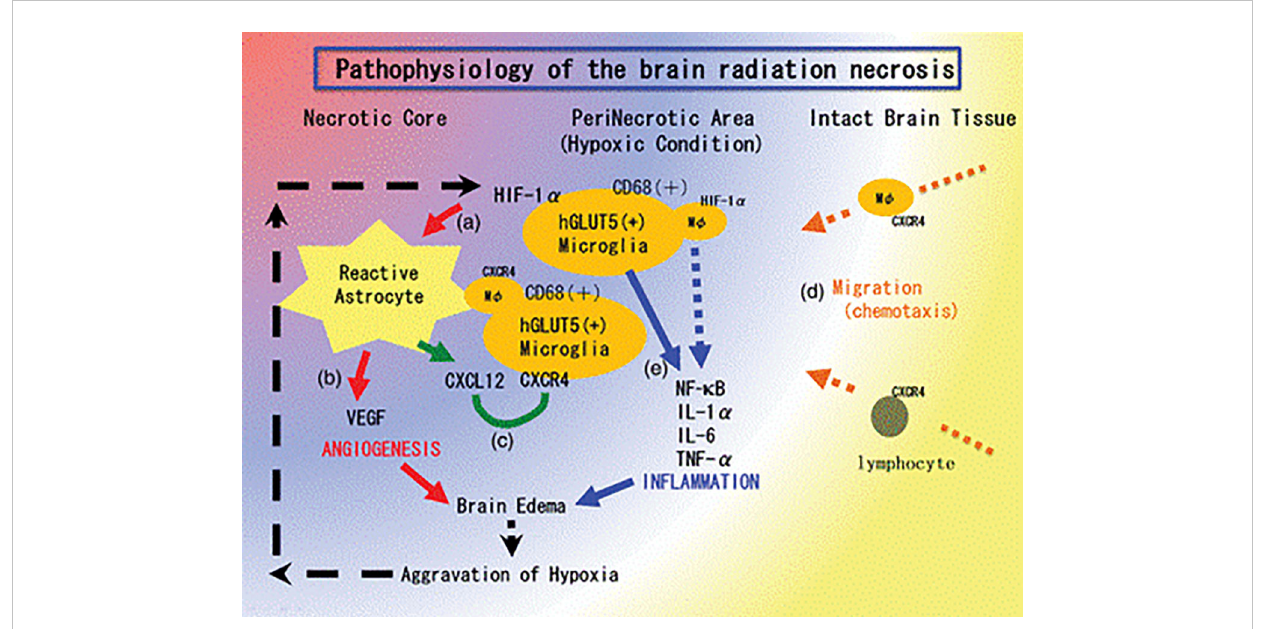
FIGURE 4 The pathophysiology of brain radiation necrosis from Yoritsune et al.